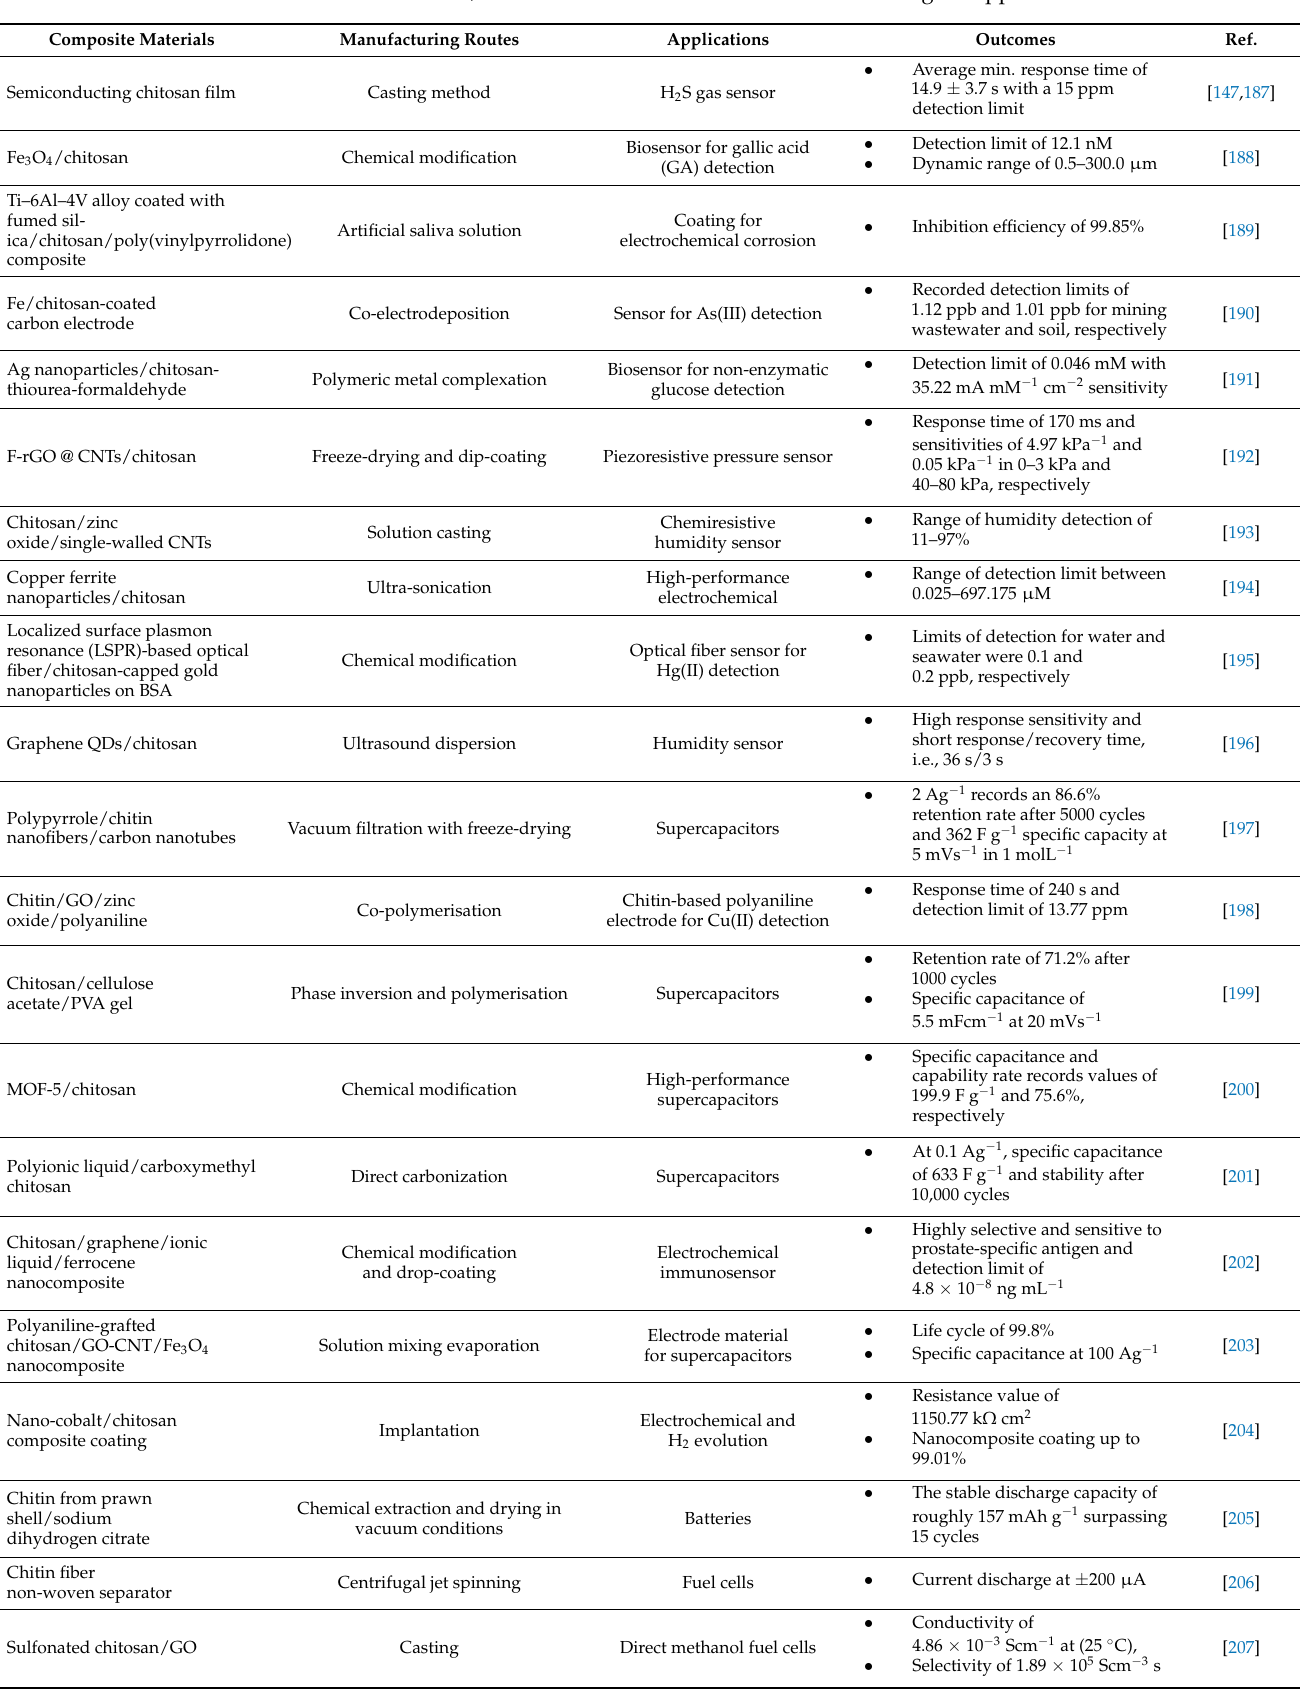
Table 2. Tabulation of chitin/chitosan-based nanomaterials and their energetic